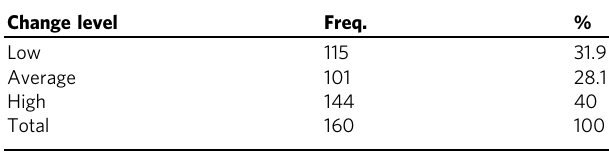
Table 9 Distribution of respondents according to the level of change in the components of cultural identity as a whole.